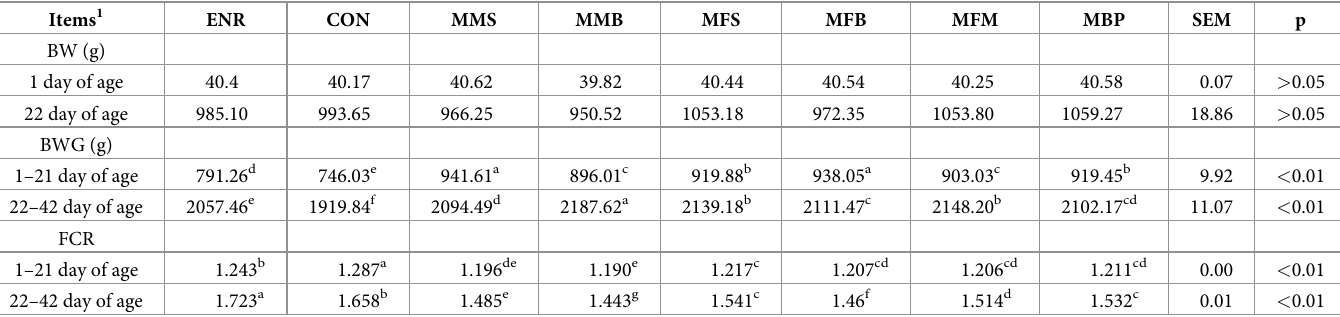
Table 2. Effects of dietary nonantibiotic alternative growth promoter combinations on body weight gain and feed conversion ratio of broilers at 21 and 42 days.